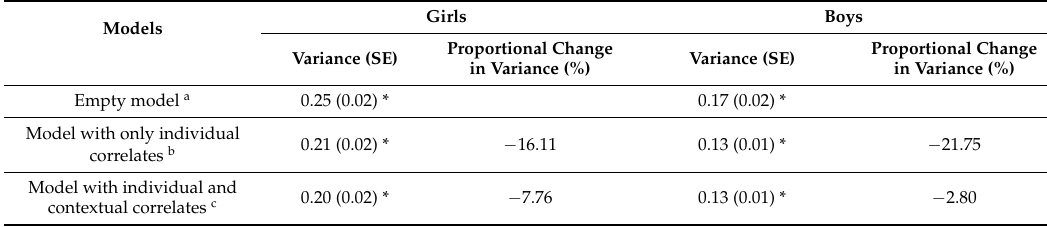
Table 2. Random Effects of School Neighbourhood on Leisure-Time Physical Activity Among Adolescents Involved in the QHSSHS, Quebec, 2010–2011 (with Multiple